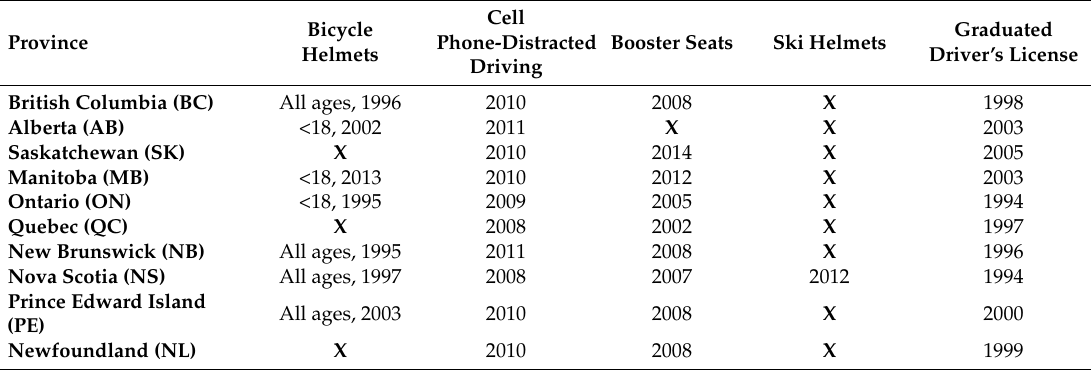
Table 1. Provincial legislation implementation dates (as of January 2015).